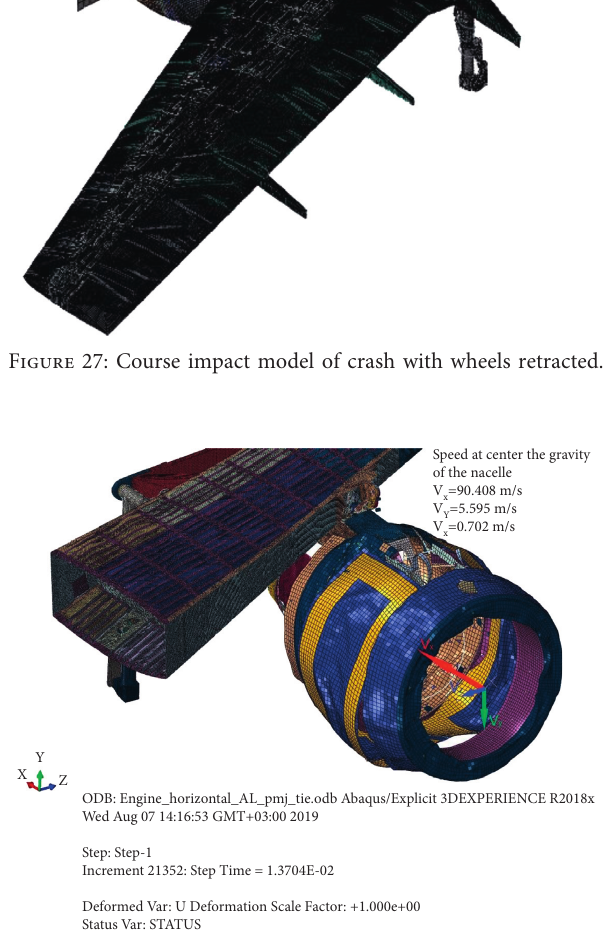
Figure 28: Deformation and velocity of center of gravity after emergency disconnection—course of impact.